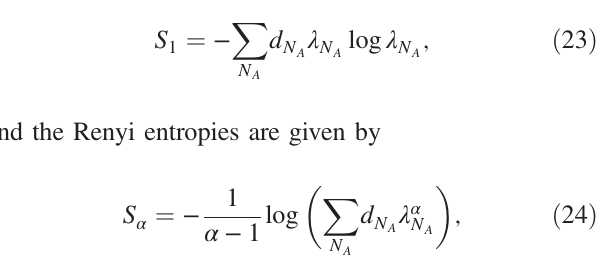
1 ), and the black circles mark the